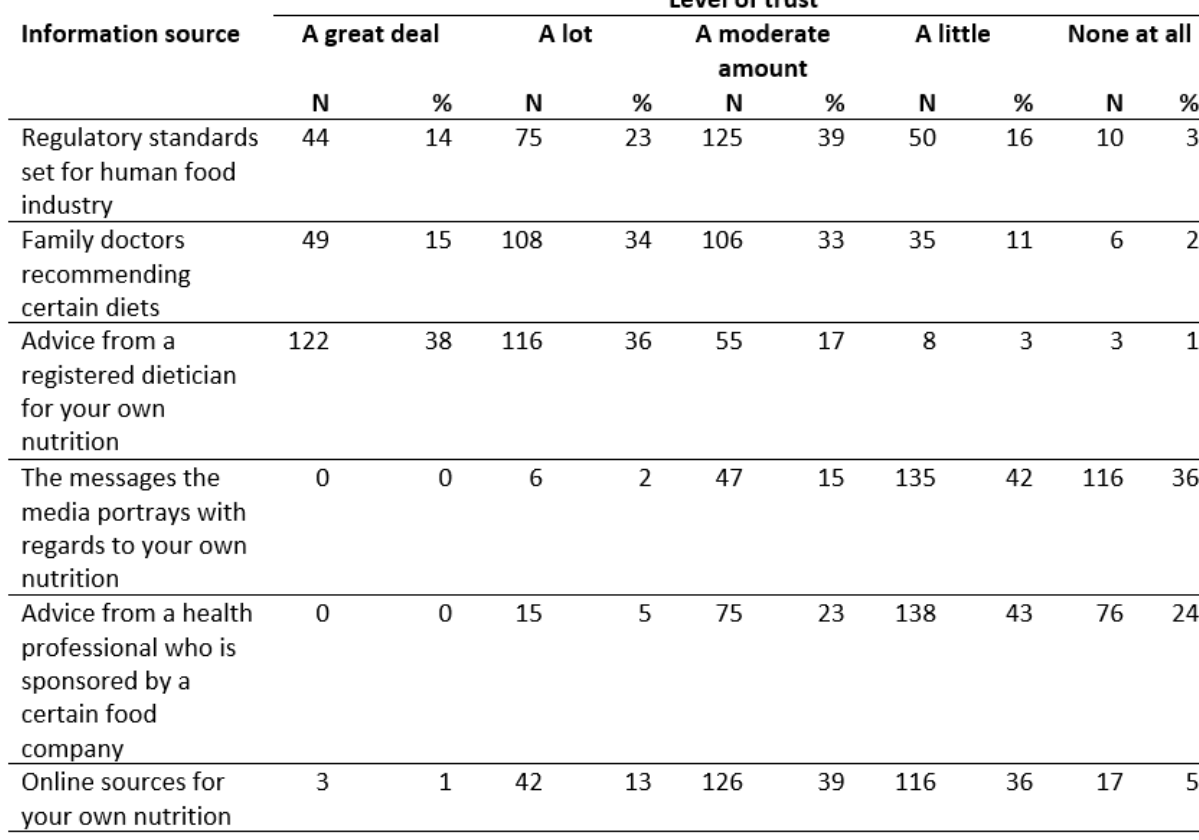
Table 3. Amount of trust placed in different information sources as self-reported by first year Canadian and US veterinary students as part of questionnaire on health and nutrition attitudes and behaviours (n=322).